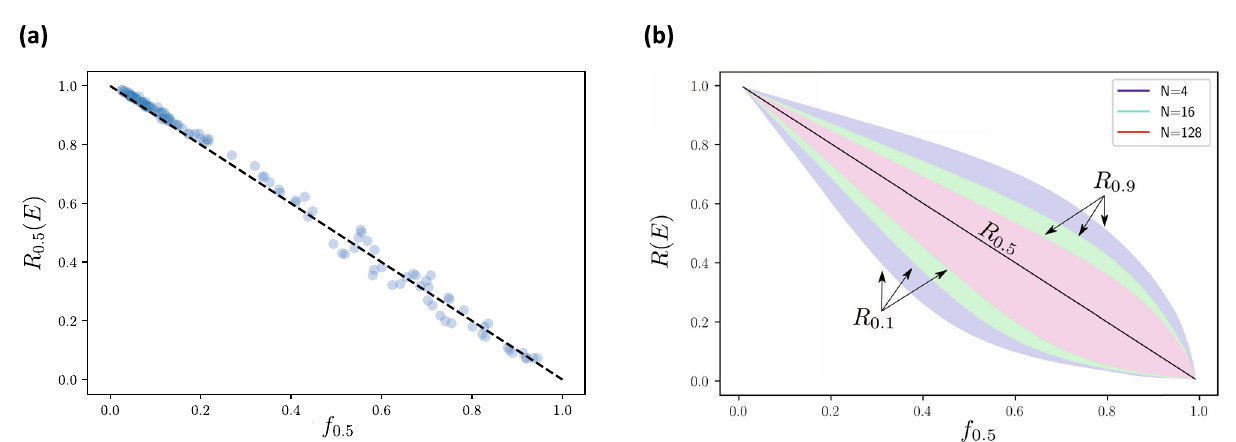
Fig. 3 Universal behaviour of the robustness of ecosystem service supply as a function of network fragility. a For 125 random ecosystem services of the form shown in Fig. 2, we uniformly sampled 5 values for species richness S between 10 and 200, 20 for functional traits N between 10 and 100 and 10 for connectance p between 0 and 0.5 and for each considered 600 extinction scenarios leading to a loss of service, drawn uniformly over the set of all possible extinction sequences. We see that the median robustness of ecosystem service supply (that is, R 0.5 ( E )) in our simpli fi ed Boolean model behaves as a simple decreasing linear function of median network fragility ( f 0.5 ). b For three values of number of traits (that is, N = 4, 16 and 128) and random values of number of species S and connectance p , we used the analytical formula in Eq. (1) to draw the contours of the bulk of the robustness distribution (that is, 10th – 90th percentiles) as a function of f 0.5 , the value of fragility associated with median robustness. We see that, at fi xed N , the percentiles can be expressed as functions of f 0.5 , with the largest spread at intermediate values of network fragility. At fi xed fragility, increasing the number of traits N reduces the width of the